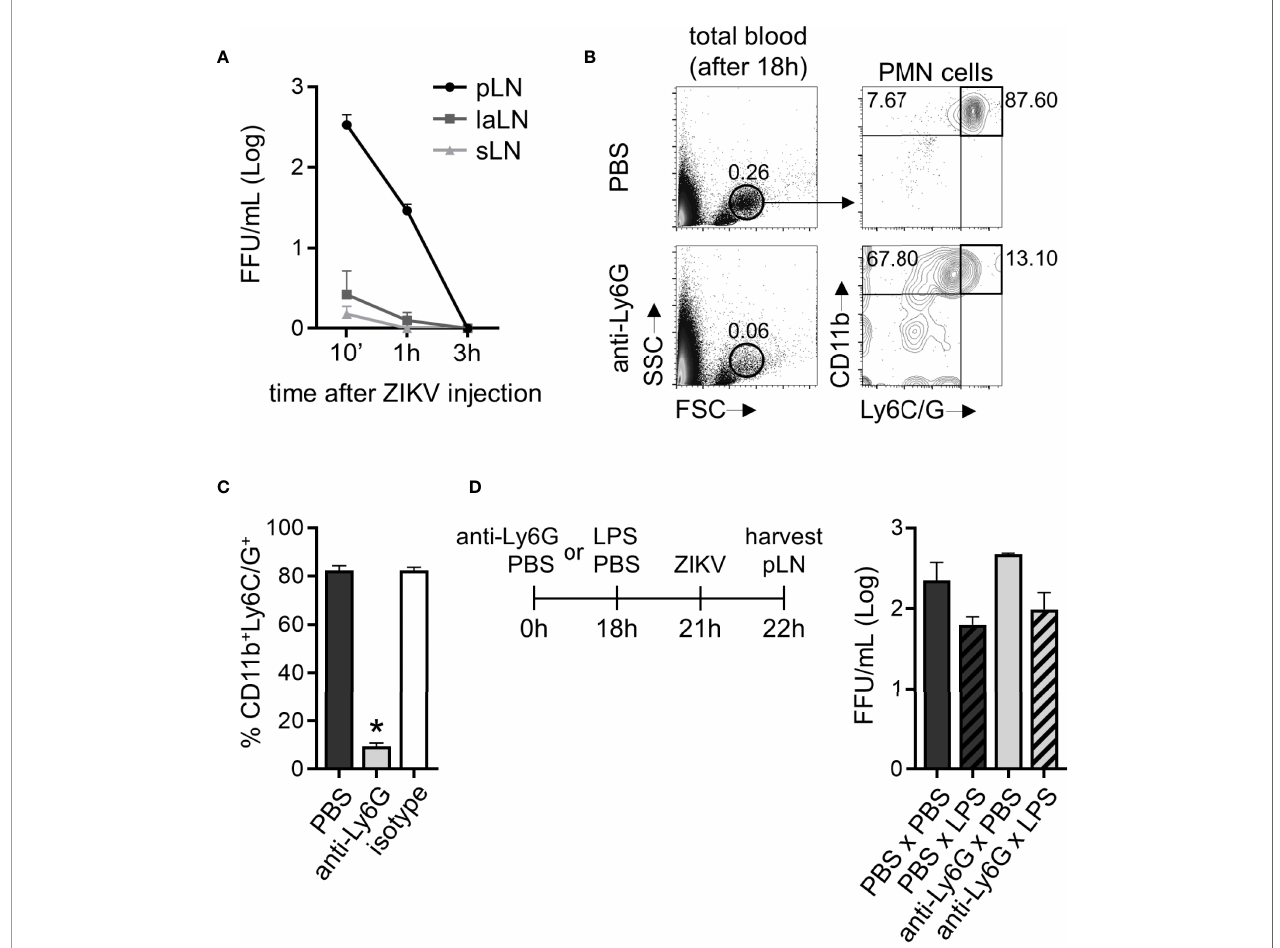
FIGURE 9 | Mice neutrophil depletion does not restrict ZIKV relocation to draining lymph nodes. (A) ZIKV loads detected in the pool of both ipsi- and contralateral popliteal (pLN), sciatic (sLN), or lumbar aortic (laLN) lymph nodes per C57BL/6 mouse after 10 minutes, 1 and 3 hours of ZIKV PE243 (5x10 5 FFU) injection to the footpad. (B) Flow cytometry plots depicting the frequency of PMN leukocytes CD11b + Ly6C/G + in the total blood content of mice 18 hours post-treatment with PBS or anti-Ly6G antibody (400 µg). (C) Frequency of CD11b + Ly6C/G + cells in the PMN population in mice treated with PBS, anti-Ly6G, or an isotype antibody for 18 hours. (D) After neutrophil depletion, mice received a footpad subcutaneous injection of PBS or LPS (1000 ng) and, 3 hours later, ZIKV PE243 (5x10 5 FFU). One hour later, ipsi- and contralateral pLNs from each mouse were harvested and pooled to determine ZIKV loads. Bars indicate SEM. Three animals per group were used in each experiment. One of three independent experiments is shown. The asterisk (*) denotes the statistical difference between PBS and anti-Ly6G